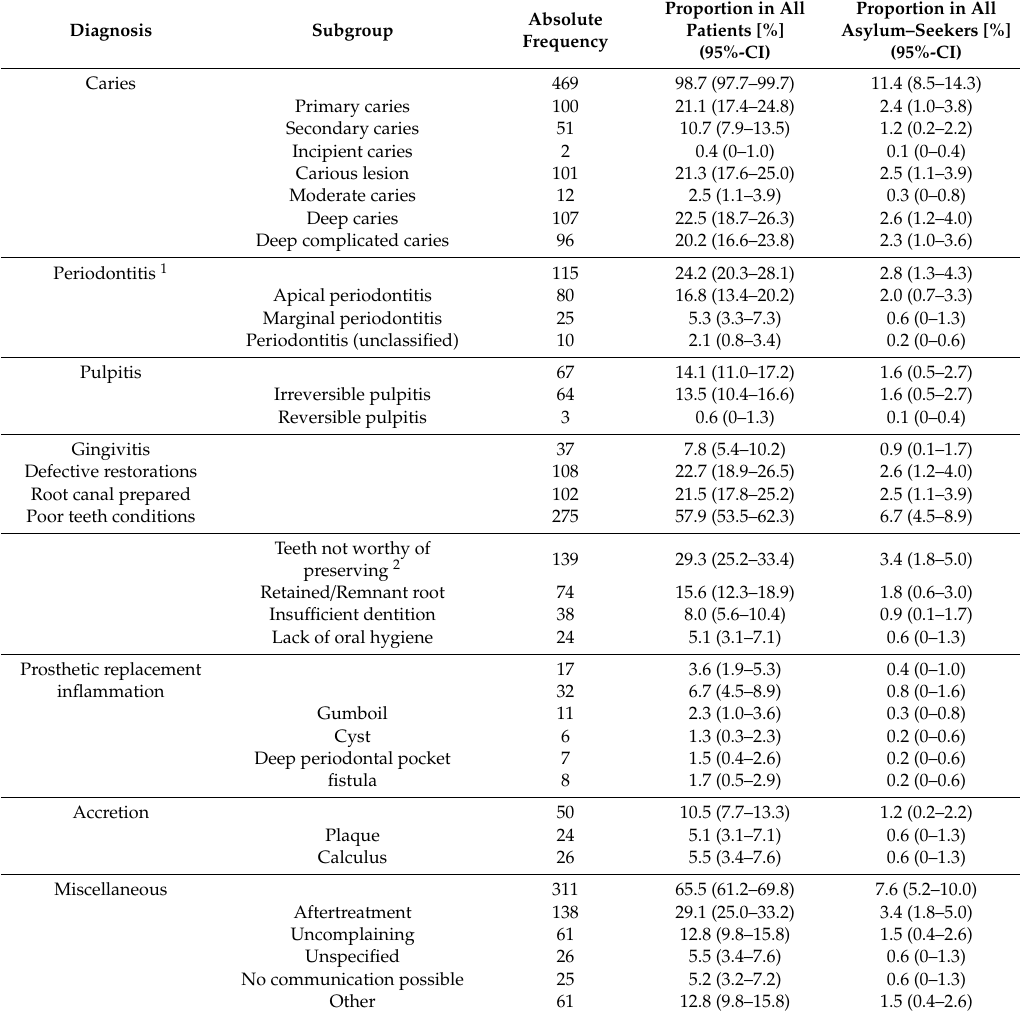
Table 2. Frequency of asylum-seekers’